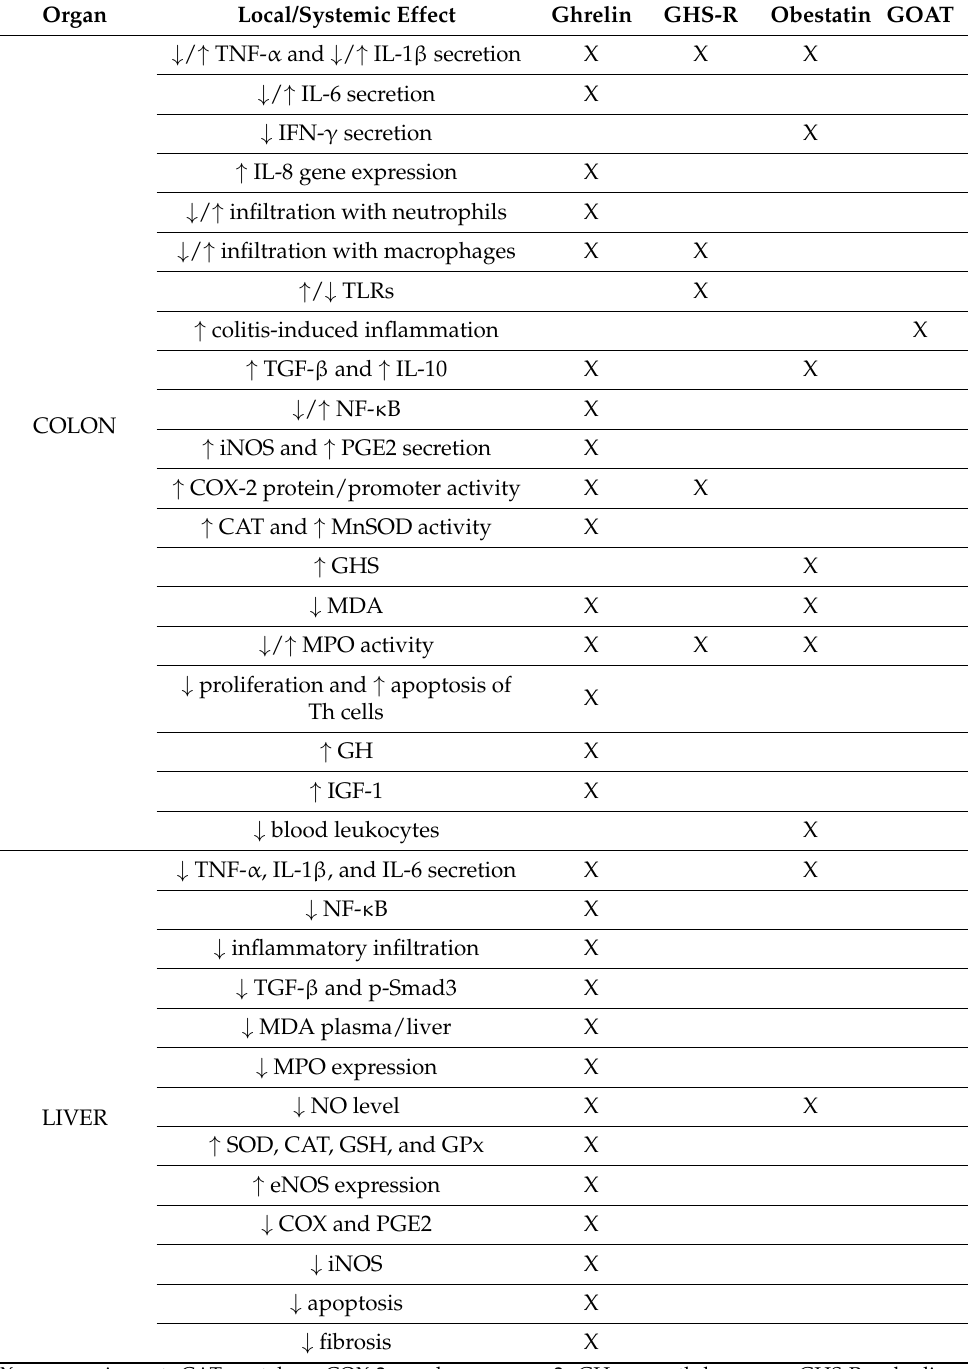
Table 5. The Main Immunomodulatory Effects of the Ghrelin System in Colon and Liver